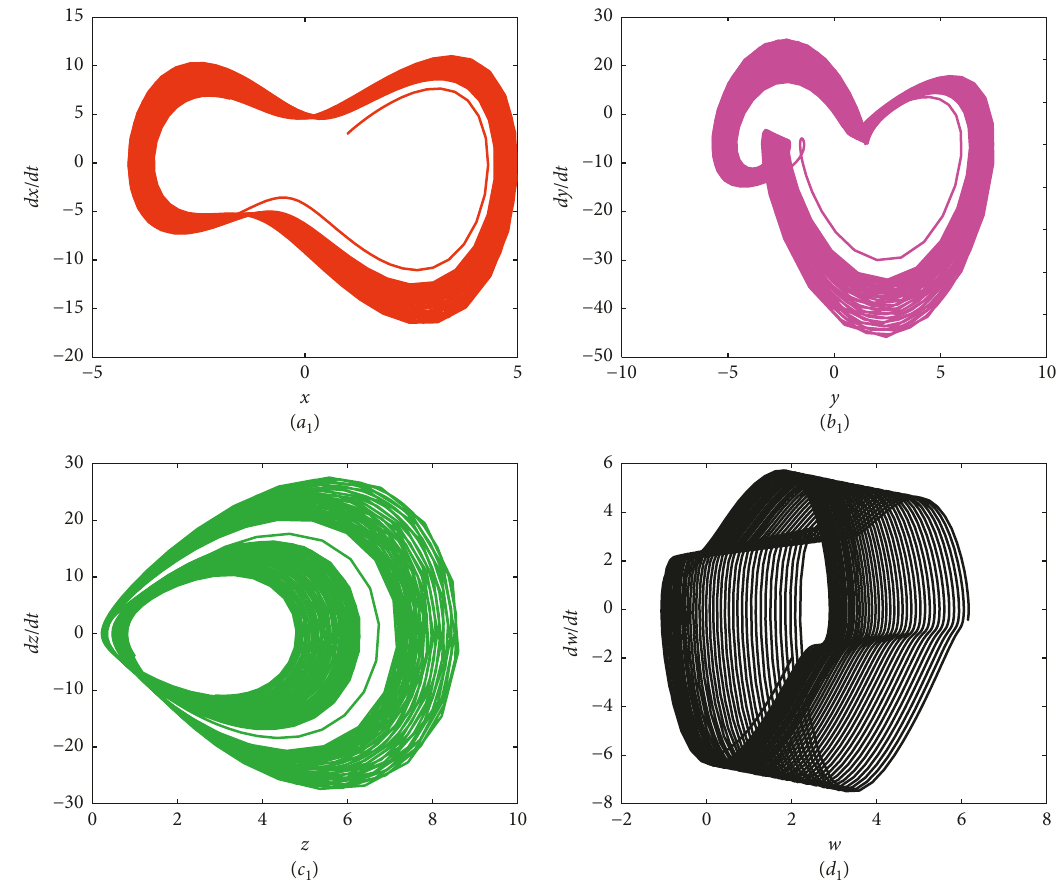
Figure 17: Phase portraits of Experiment 3 with a � 0 . 1 , t � 100: ( a ) phase diagram of w . ( d 1